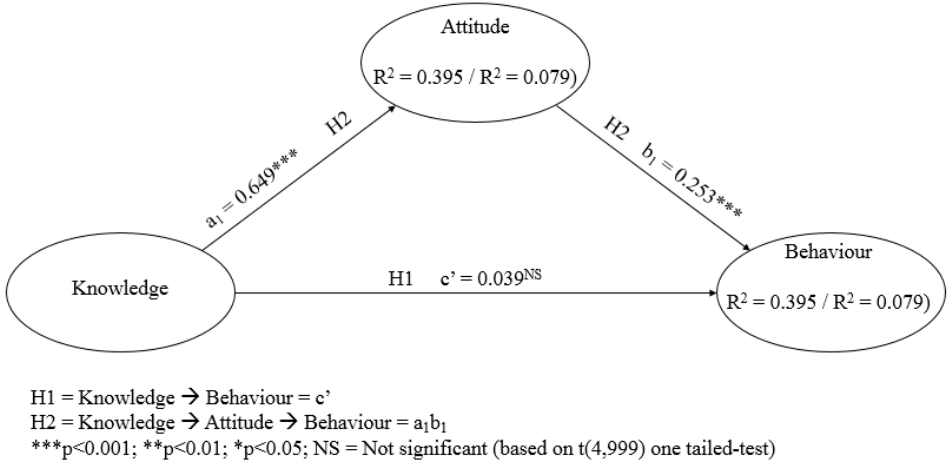
Figure 2. Final structural model.